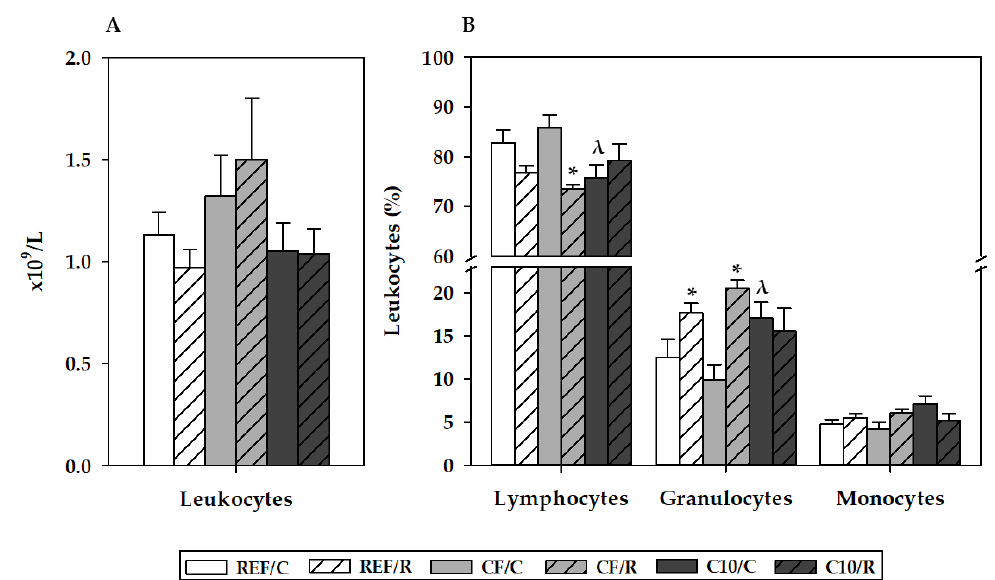
Figure 3. Blood counts of leukocytes ( A ) and proportions of lymphocytes, granulocytes, and mono- cytes ( B ) 16 h after performing the final exhaustion test. REF, reference diet; CF, 5% cocoa fiber- enriched diet; C10, 10% cocoa-enriched diet. The control (C) groups are represented by smooth bars, and the runner (R) groups are represented by striped bars. Data are expressed as mean ± SEM (n = 8). Statistical differences (a Kruskal – Wallis test followed by a Mann – Whitney U test): * p < 0.05 vs. the C group in the same diet; λ p < 0.05 vs. the same exercise condition in the CF diet. With regard to results related to red blood cells (Figure 4), erythrocyte counts, hemo- globin (HGB) concentration, and hematocrit (HCT) were not affected after 16 h of an acute exercise. However, there was an increase in the erythrocyte counts and HCT after both C10 and CF diets ( p < 0.05) and in the HGB concentration after following the C10 diet ( p = 0.001).